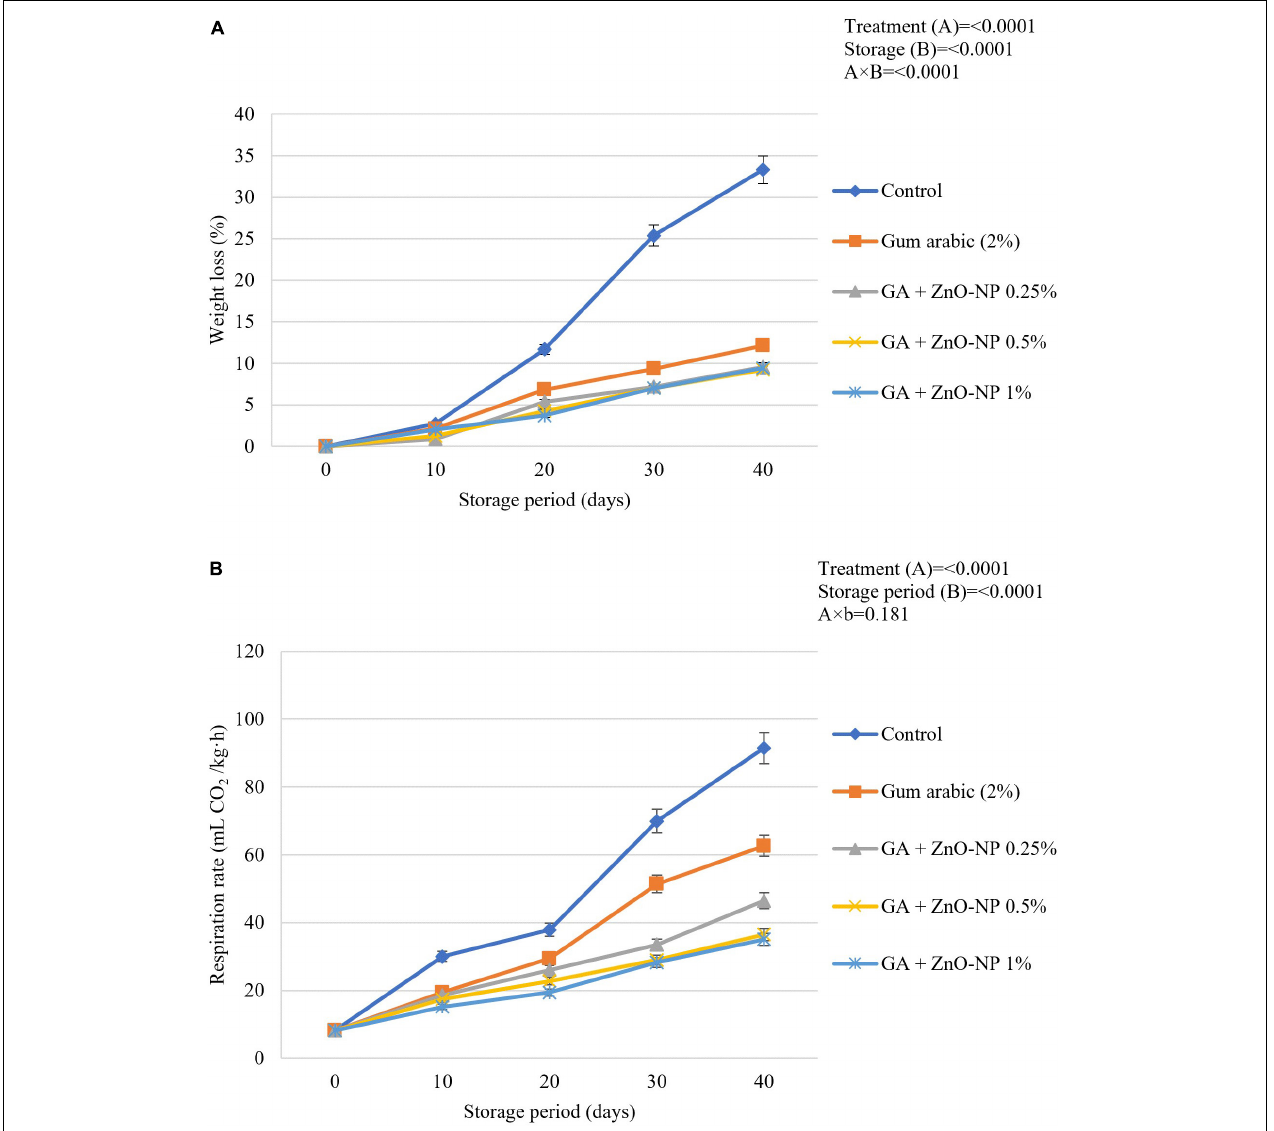
FIGURE 3 | (A) Changes in weight loss and (B) respiration rate of ‘Kinnow’ mandarin fruit during storage for 40 days at 5 ± 1 ◦ C. Error bars denote the standard error (SE) of the mean. Means ± standard errors presented. To determine the interaction effects, factorial ANOVA was performed for the main factors, treatment, and storage time. GA + ZnO-NP, gum arabic + zinc oxide